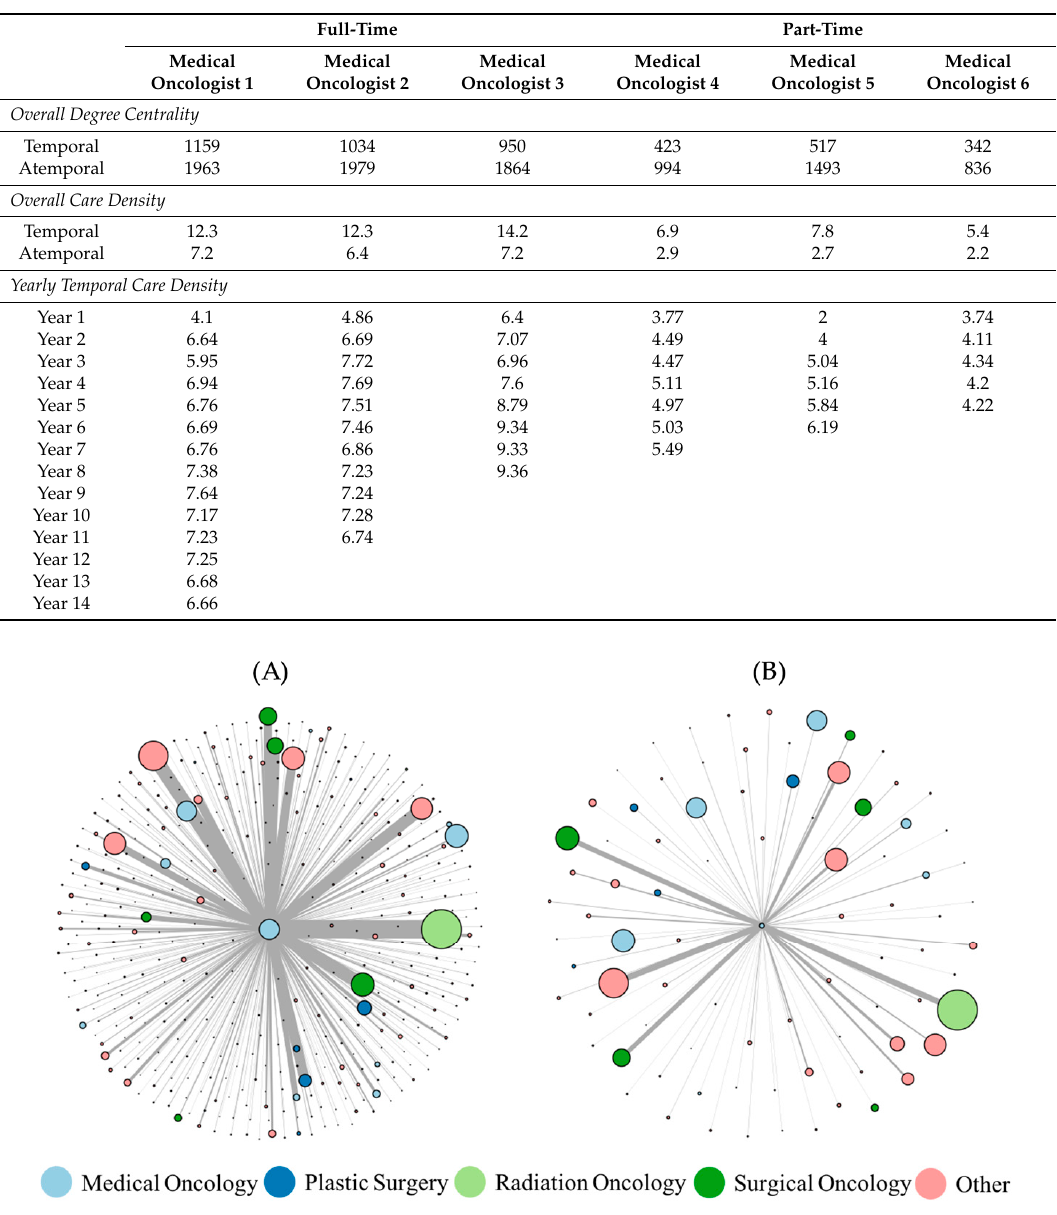
Figure 3. Care density for ( A ) top full ‐ time provider and ( B ) top part ‐ time provider by patient volume. The top full-time provider and top part-time provider are the central nodes in each respective graph. The top full ‐ time provider and top part ‐ time provider are the central nodes in each respective graph. Edges are calculated using the temporal network creation Edges are calculated using the temporal network creation method.